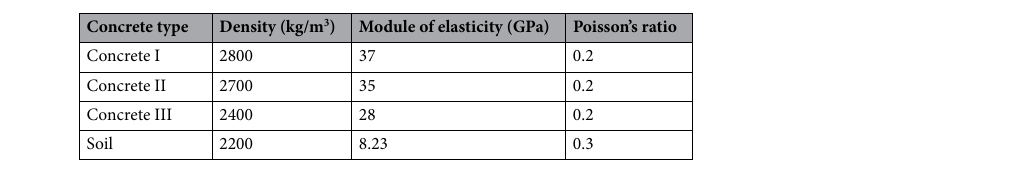
Table 3. Mechanical properties of concrete and soil models.